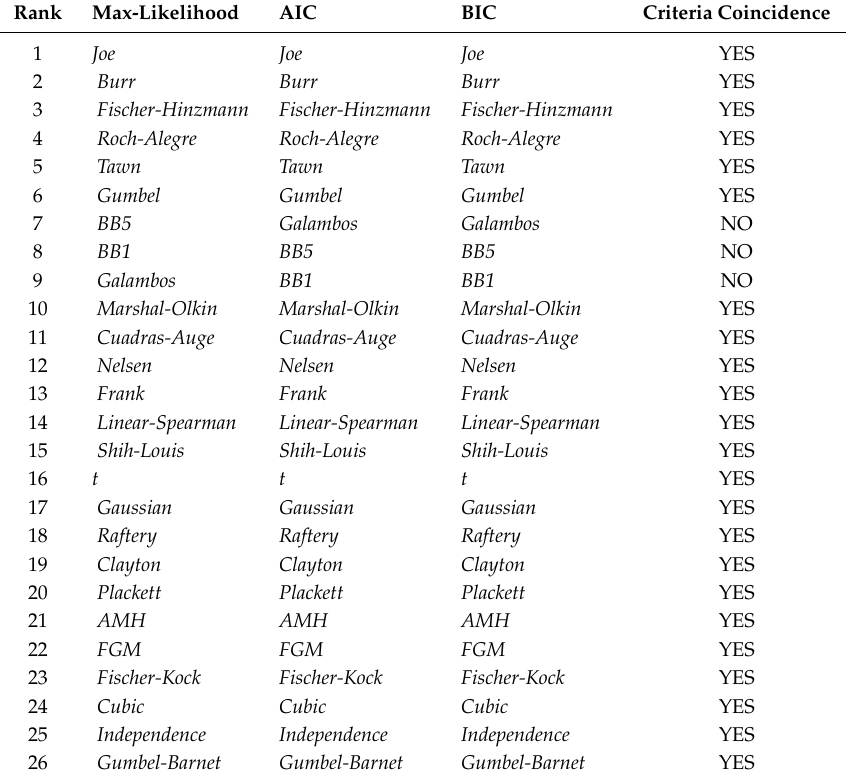
Table 4. Selection of copulas fitted to the DJIA index (1928–2009) based on three different criteria. Performance-criterion ranking amongst the implemented copulas. Rank Max-Likelihood AIC BIC Criteria